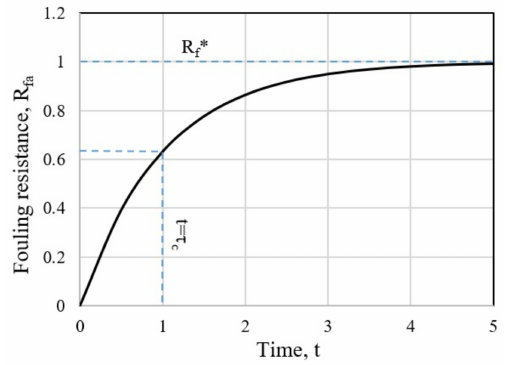
Figure 5. Asymptotic